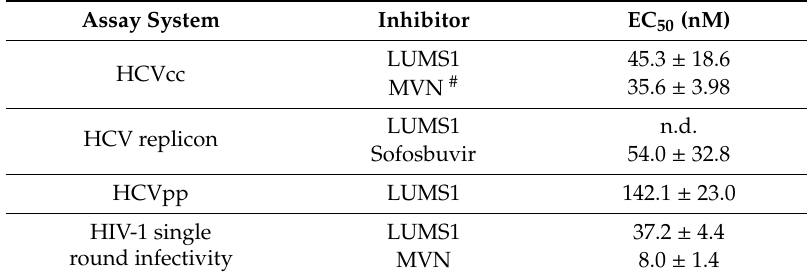
Table 1. Overview of antiviral activity of LUMS1 and compounds used as positive control.